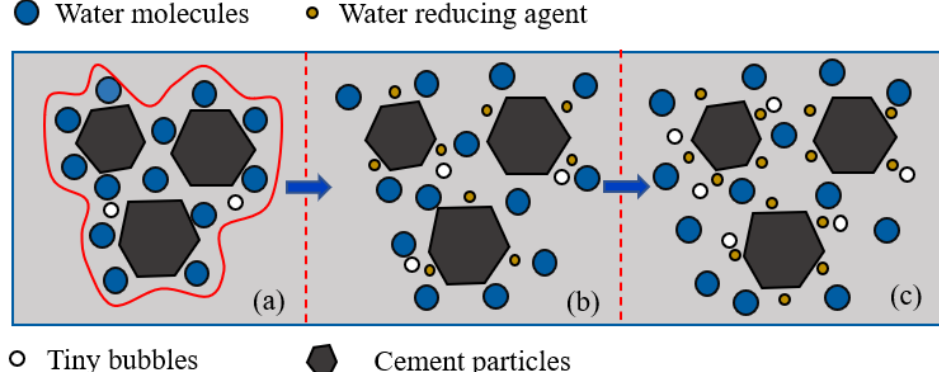
Figure 16. Strength mechanism of concrete strengthened by superplasticizer. ( a ) No superplasticizer added. ( b ) Added appropriate amount (0.5%–1.0%) of superplasticizer. ( c ) Excessive (>1.0%) superplasticizer was added.